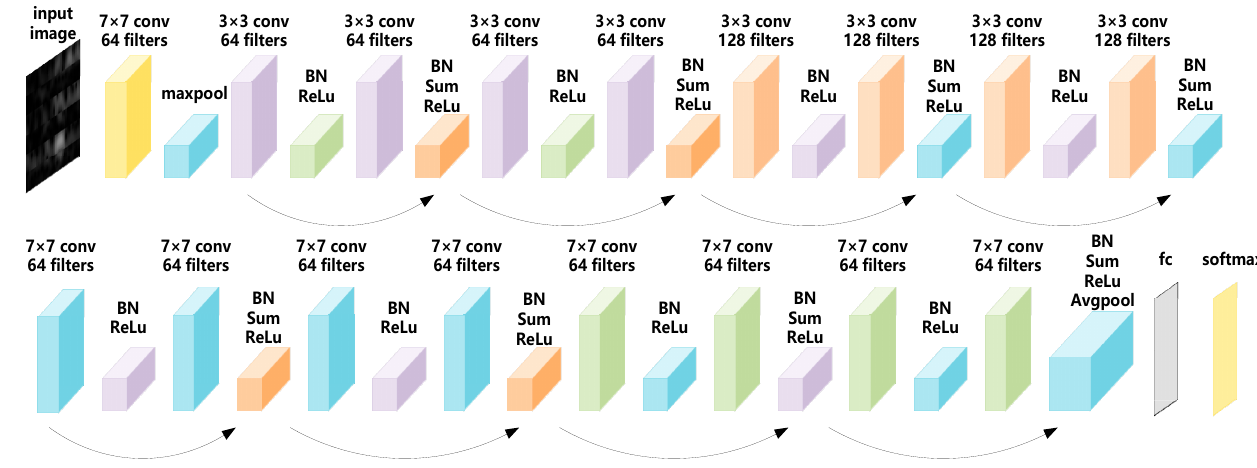
Figure 5. ResNet18 structure diagram.